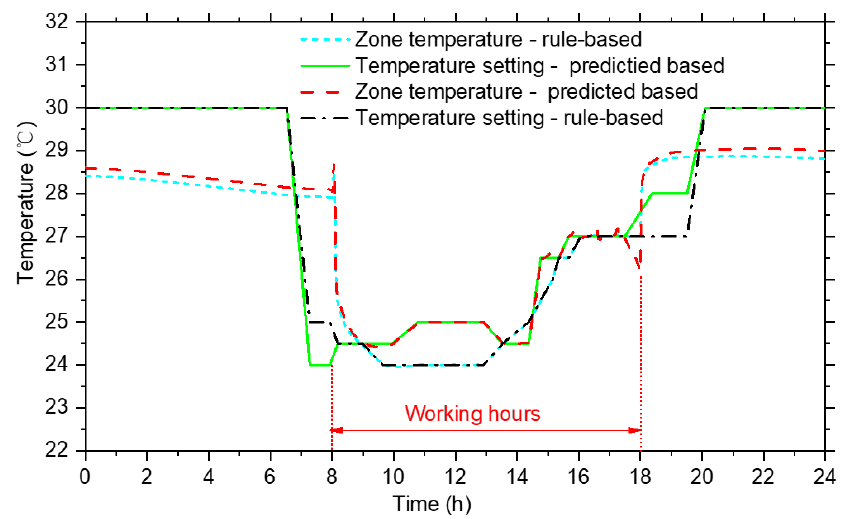
Figure 11. Temperature setting and real-time zone temperature of the two proposed control strate- gies.